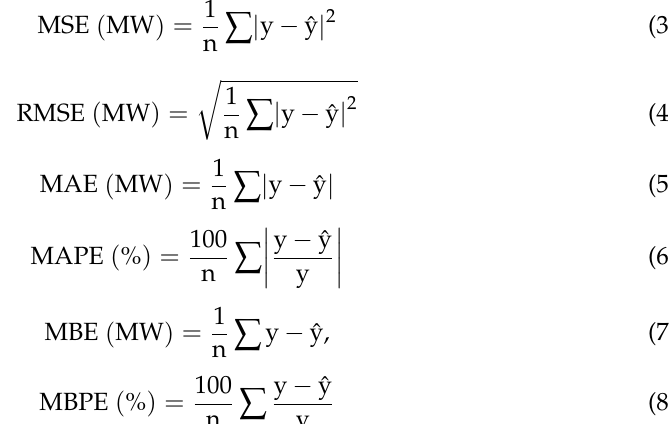
(RMSE), Mean Absolute Error (MAE), Mean Absolute Percentage Error (MAPE), Mean Bias Error (MBE), Mean Bias Percentage Error (MBPE) were calculated for each trained model.